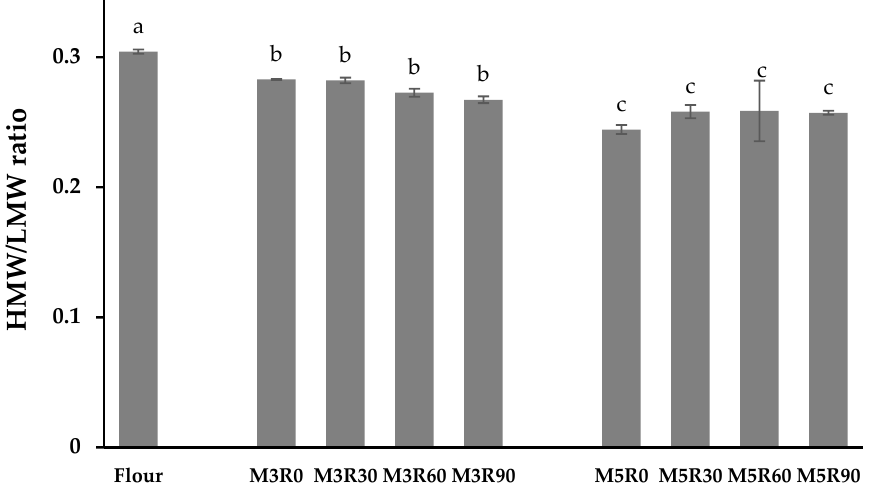
Figure 4. High-molecular weight (HMW)/low-molecular weight (LMW) ratio of the GMP. Data are mean values ± standard variation of three replications and different letters indicate a significant difference at p < 0.05. Flour: wheat flour without mixing or resting. M3R0–M3R90: mixing for 3 min and resting for 0, 30, 60, and 90 min, respectively. M5R0–M5R90: mixing for 5 min and resting for 0, 30, 60, and 90 min, respectively.